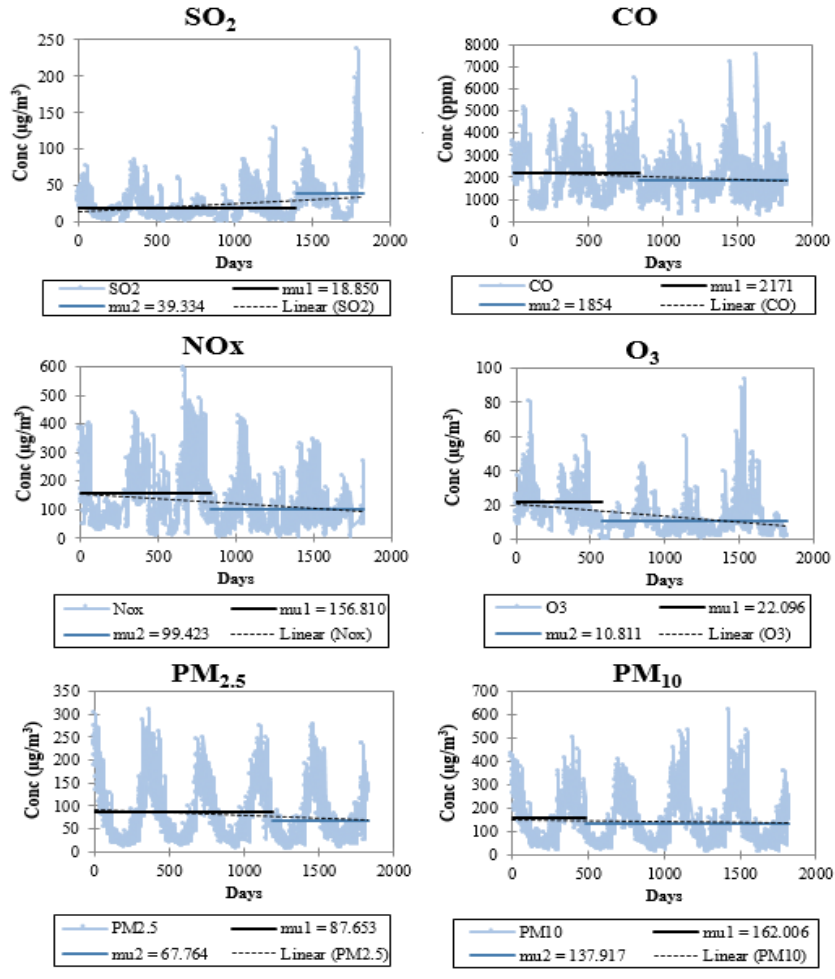
Fig. 3: MK trend analysis with homogeneity test among the concentration of air pollutants over study period